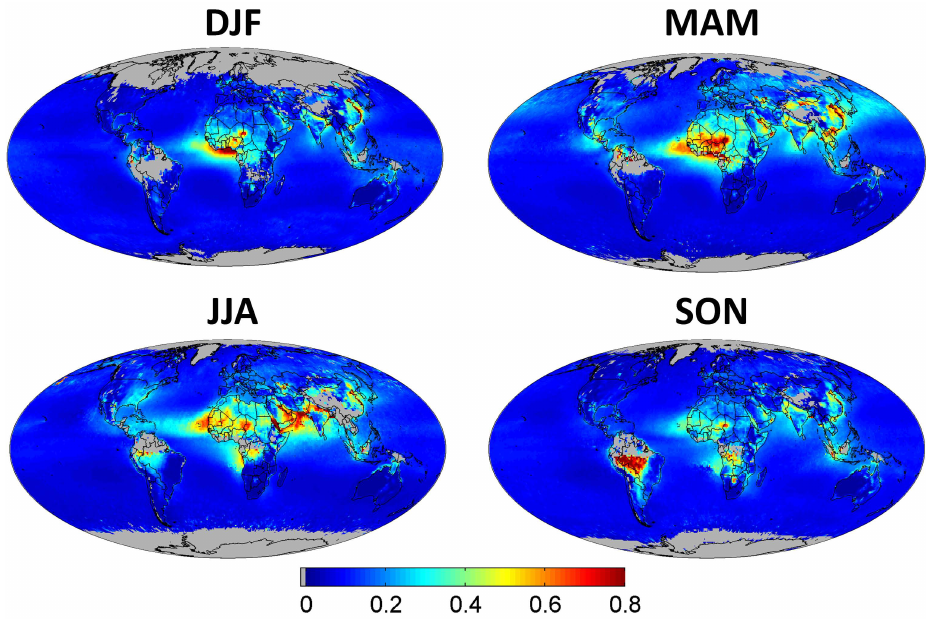
Fig. 1. SeaWiFS seasonally averaged AOD at 550 nm from 1998–2010. Regions shaded in grey indicate insufficient sampling sizes of aerosol retrievals due to the presence of snow/ice or frequent cloud cover.